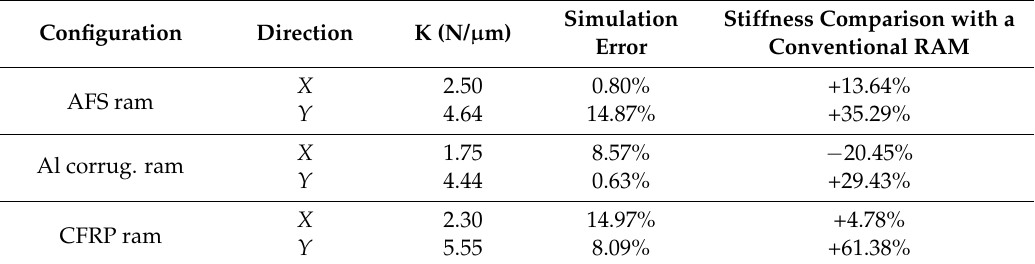
Table 5. Static test results: a comparison of the structure